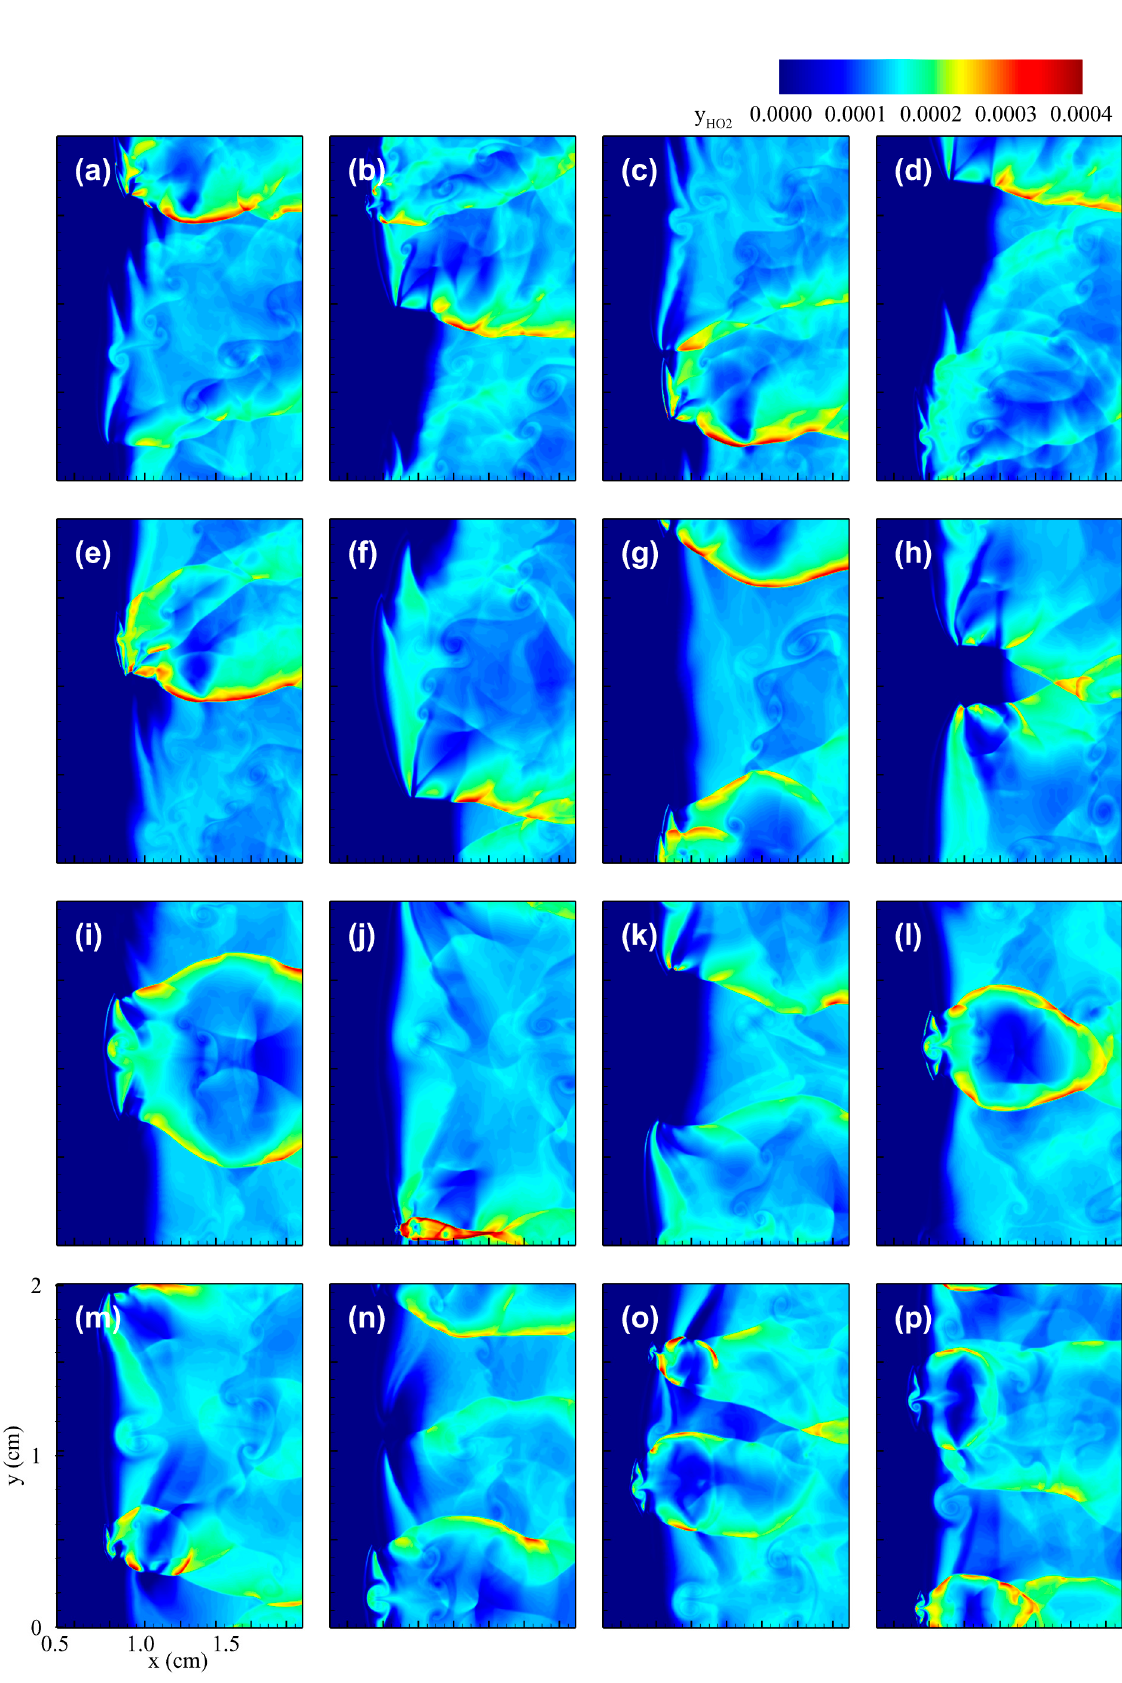
Figure 16. HO 2 distribution during the bifurcation process (depicting the onset of micro-explosion). The subfigures are plotted in temporal sequence ( a – p ).